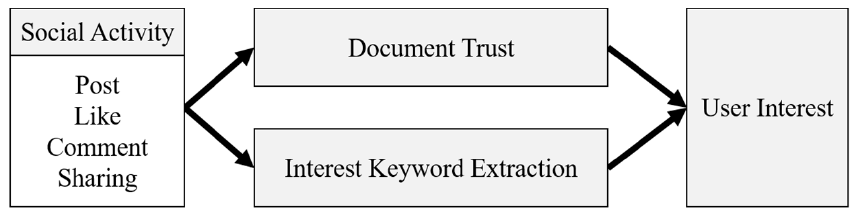
Figure 2. Determination procedure of user interest.